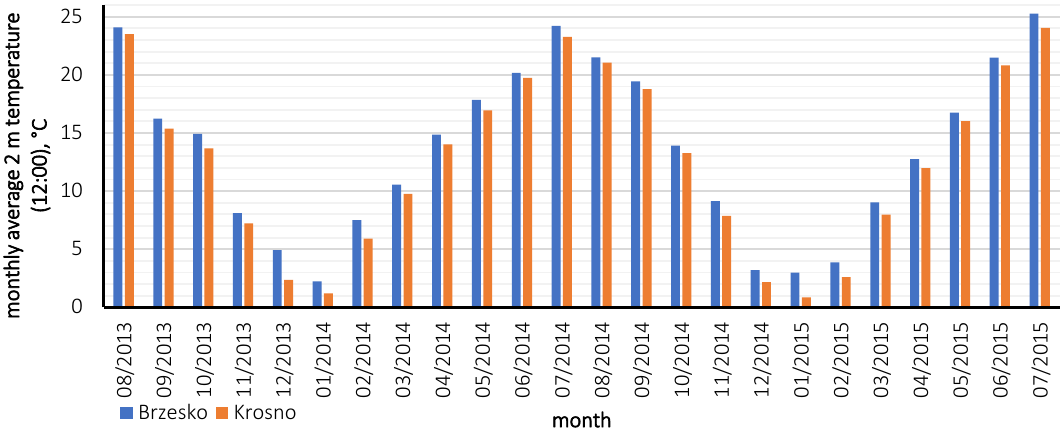
Figure 9. The comparison of the monthly average outdoor 2-m temperature (at 12:00 p.m.) for Brzesko and Krosno (from 1 August 2013 to 31 July 2015). Source: own study based on References [47,48].